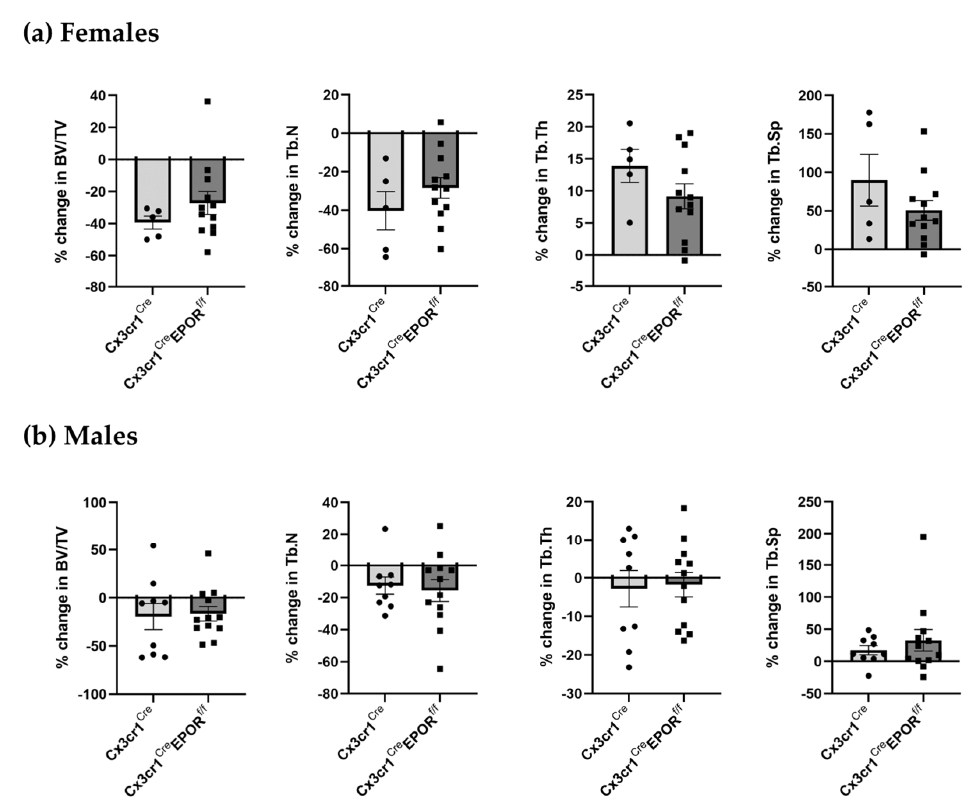
Figure 4. EPOR deletion in the Cx3cr1-expressing monocytic lineage somewhat mitigates EPO-induced bone loss. µ CT analysis of the distal femoral metaphysis of saline- and EPO-injected 12-week-old ( a ) female (n = 5–12 in each group) and ( b ) male (n = 9–12 in each group) transgenic mice carrying a conditional knockout of EPOR in the monocytic lineage Cx3cr1 Cre EPOR f/f as compared to their Cx3cr1 Cre controls. Data are represented as the extent of the reduction in trabecular bone parameters in EPO- versus saline-injected mice in each group. All data are mean ± SEM. Data were analyzed by Student’s t−test.